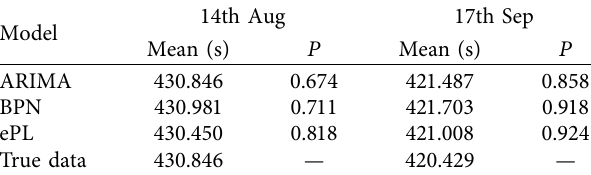
Table 2: The observation values of the t -test statistic.